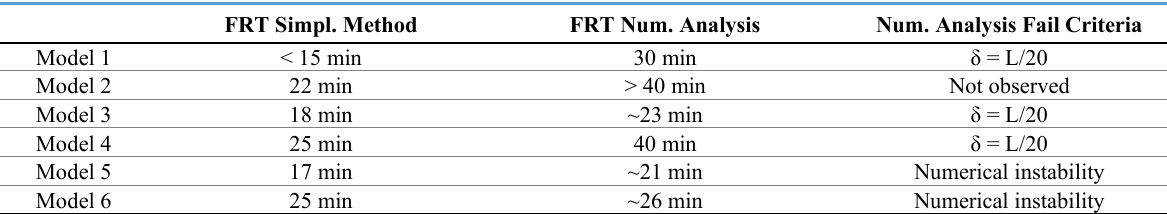
Table 4. Simplified method and numerical analysis FRTs comparison. FRT Simpl. Method FRT Num. Analysis